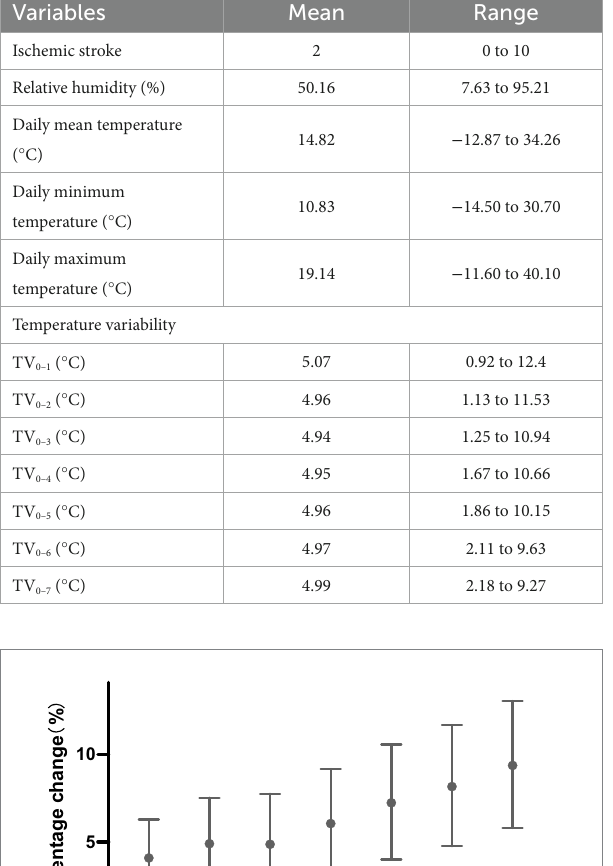
TABLE 2 Summary statistics of daily onset for ischemic stroke, weather conditions, and temperature variability in Tianjin, 2011–2020.